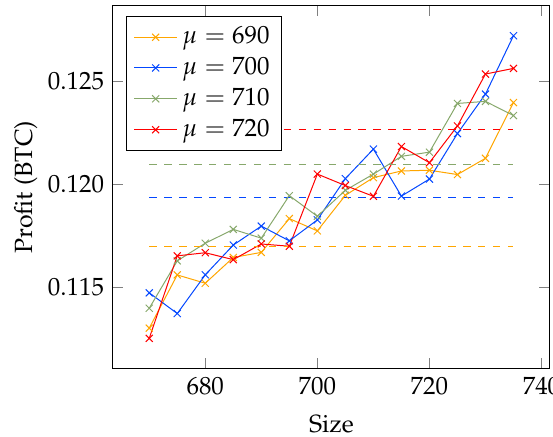
Figure 2. The graph shows how an increasing size of a block influences the average profit obtained from fees. The parameters for the distribution for block size are σ 2 = 25 and µ variable and for the reward µ = 17 and σ 2 = 2. Dashed lines represent the values computed without